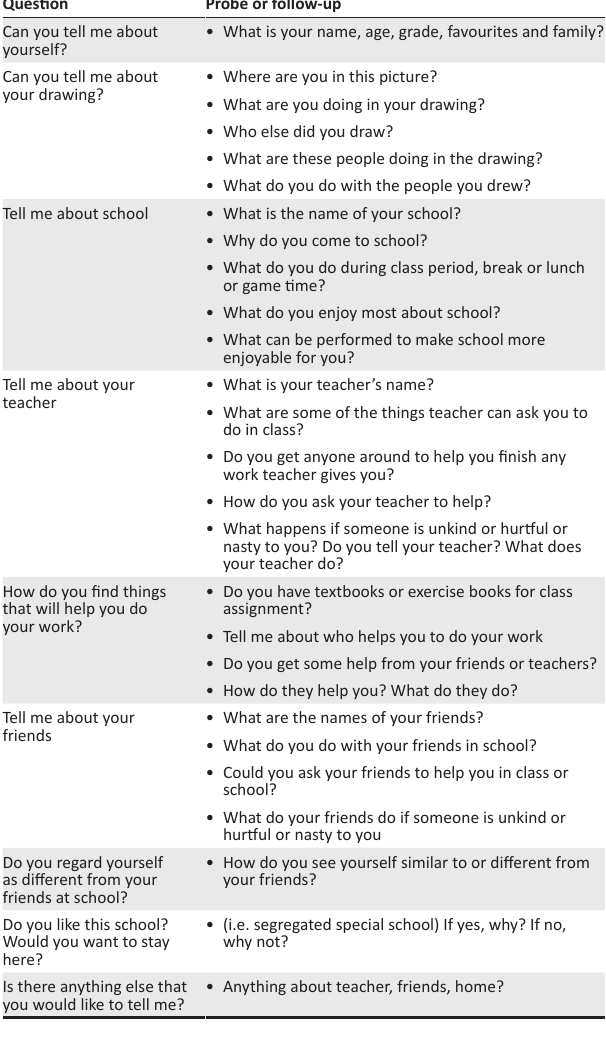
TABLE 1: Semi-structured interview